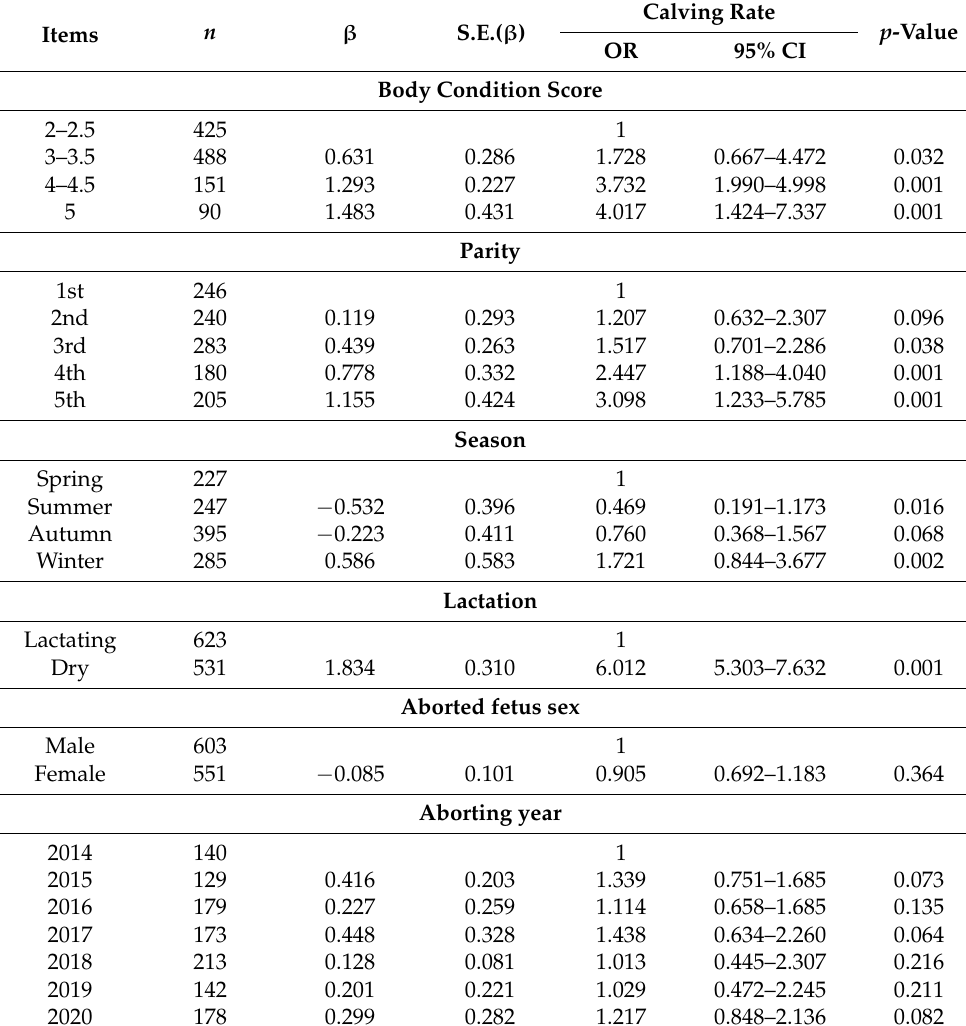
Table 3. Logistic regression analysis of risk factors associated with calving rates of Egyptian buffaloes.